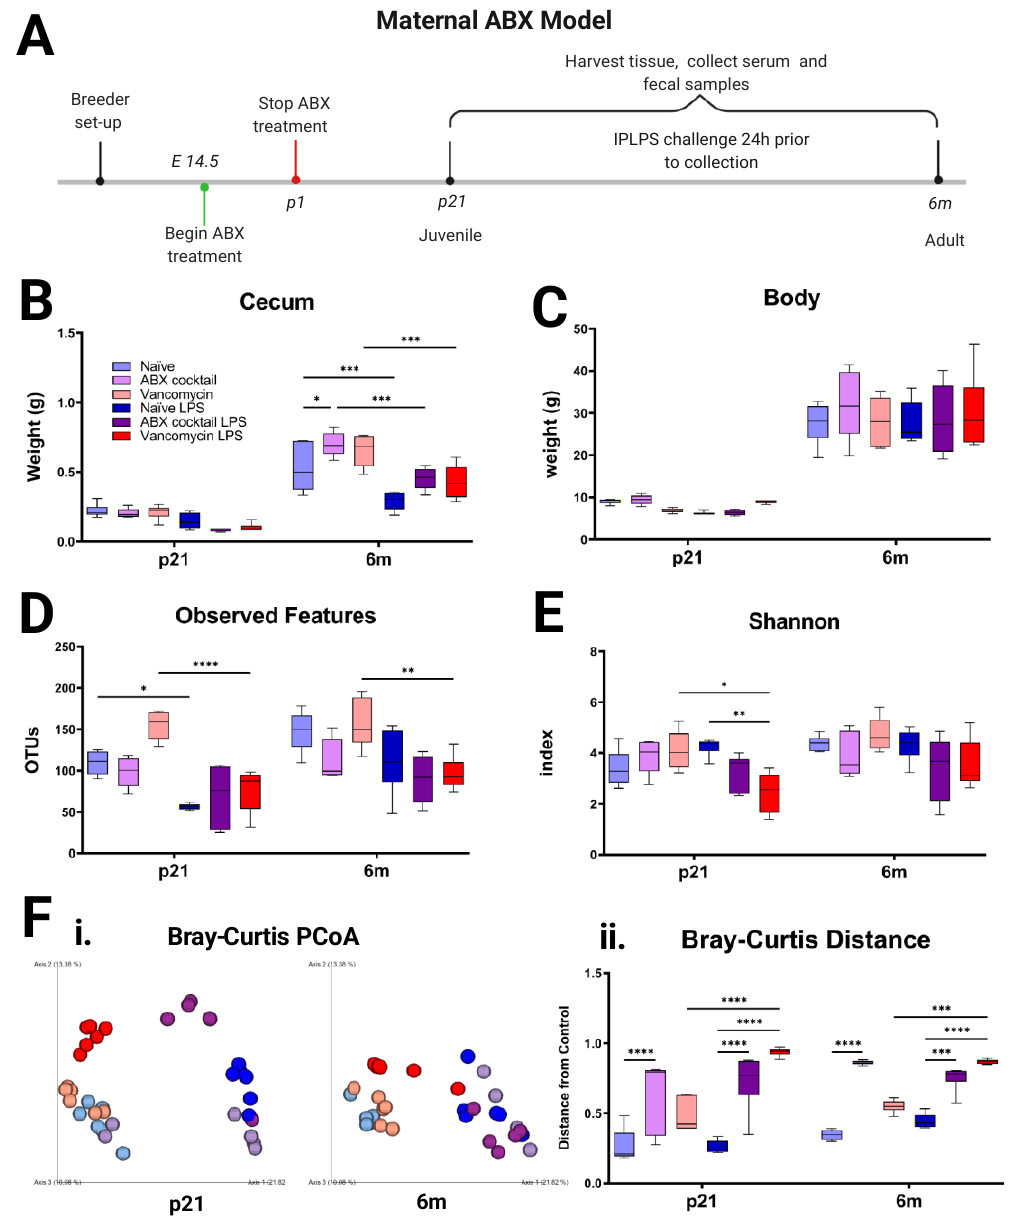
Figure 1. Prenatal ABX administration alters the gut’s microbiota diversity. ( A ) Experimental timeline showing maternal ABX treatment, offspring LPS challenge, and collection days. ( B , C ) Effect of ABX treatment and LPS challenge on cecum weight and body weight. ( D , E ) α -diversity indexes using OTUs and Shannon index based on the Illumina sequencing data ( F ) β -diversity indexes using (i) principal coordinate analysis (PCoA) plot and (ii) box plots of distances based on Bray – Curtis dissimilarity between samples. Each color represents a unique prenatal exposure baseline combined with or without stimulation: naive = light blue, vancomycin = light red, ABX-cocktail = light purple, naive LPS = blue, vancomycin LPS = red, and ABX-cocktail LPS = purple. Naive, vancomycin, and ABX-cocktail samples were run in parallel, the number of mice in each group were male n = 3 and female n = 3. The levels of significance ( p -values) were determined by two-way ANOVA test followed by Tukey post-correction test for multiple comparisons. The values represent means + SEM, * p ≤ 0.05, ** p ≤ 0.01, *** p ≤ 0.001 , and **** p ≤ 0.0001.